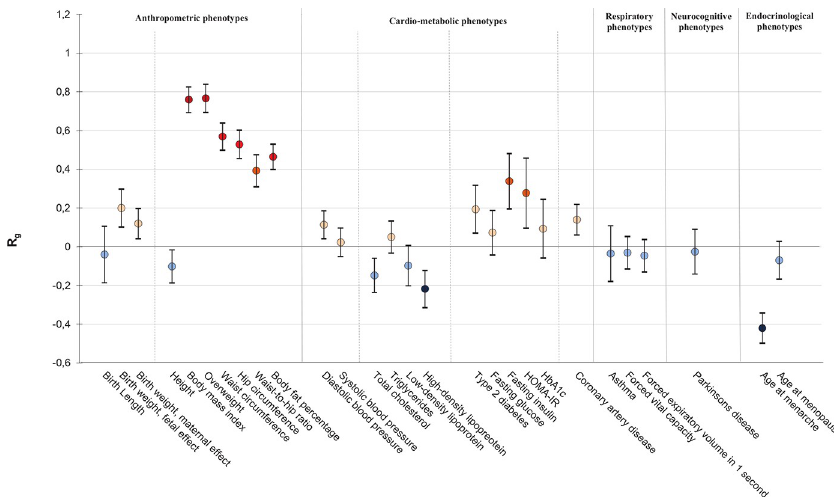
Fig 3. Genome-wide genetic correlations between childhood BMI and adult traits and diseases. On the x-axis the traits and diseases are shown. On the y-axis the genetic correlations (R g ) and corresponding standard errors, indicated by error bars, between childhood BMI and each trait were shown, estimated by LD score regression. The genetic correlation estimates (R g ) are colored according to their intensity and direction. Red indicates positive correlation, blue indicates negative correlation. References can be found in S11 Table.